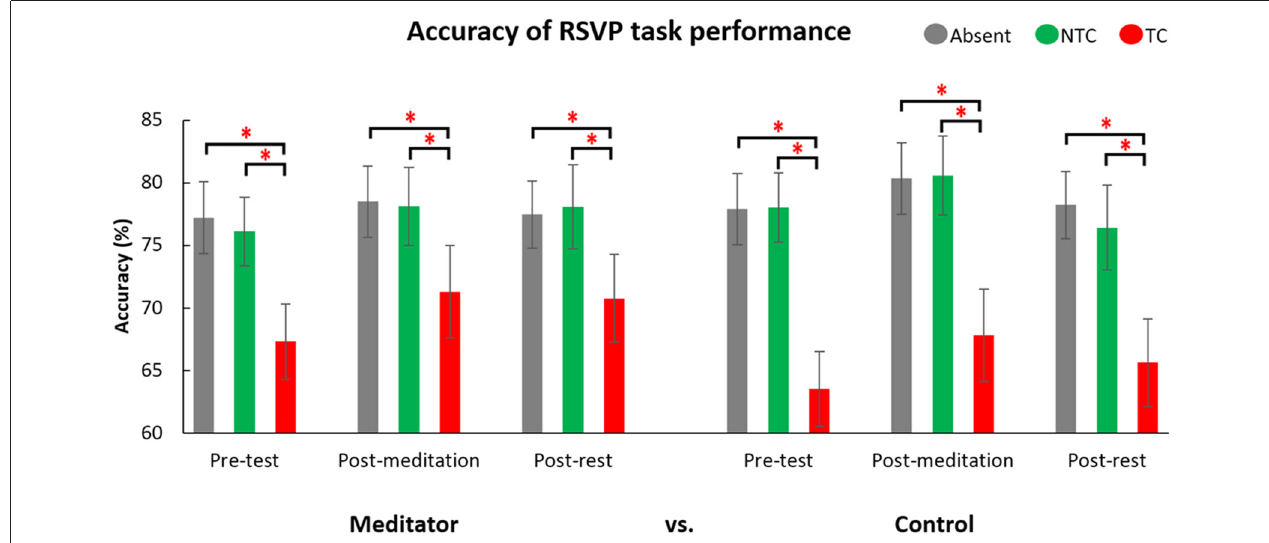
FIGURE 4 | Behavioral performance on the RSVP task for different distractor types and interventions. The gray bars are the distractor absent condition (Absent (grey)), the green bars are the non-target color distractor condition (NTC (green)), and the red bars are target-colored distractor condition (TC (red)). The accuracy of the TC distractor condition was significantly lower than Absent and NTC across groups and interventions of meditation and rest. Error bar indicate 95% confidence intervals. The asterisks ( ∗ ) indicate statistically significant differences ( p < 0.05).